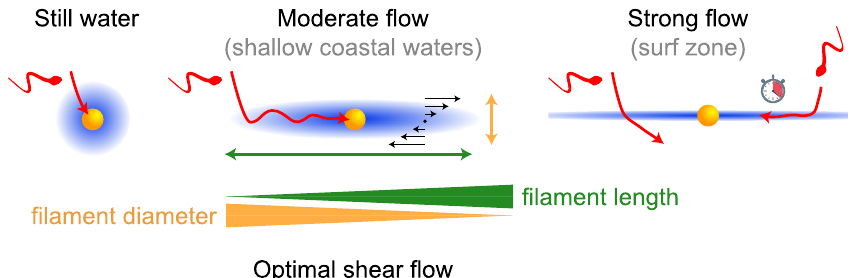
Fig 5. Proposed mechanism explaining optimal flow strength for sperm chemotaxis. Egg cells (yellow) release signaling molecules (blue) that guide sperm cells of marine species with external fertilization (red). External flows (black arrows) stretch concentration gradients into millimeter-long filaments. If sperm cells encounter such filaments, they can “surf” by chemotaxis towards the egg. In strong flows, however, sperm cells may fail to follow the filament after encounter, because the effective diameter of filaments is too small. Additionally, in very long filaments, sperm cell may not reach the egg within the sperm-egg exposure time (which is set by the lifetime of the smallest eddies for turbulent flow). Thus, it is not the total volume of the chemoattractant plume that determines fertilization success, but the geometric shape of filaments. The competition between increasing filament length, which favors sperm-egg encounters, and decreasing filament diameter, which jeopardizes filament surfing, sets an optimal flow strength that maximizes sperm-egg encounters. The optimal flow strength predicted by our theory matches physiological flow strengths in typical